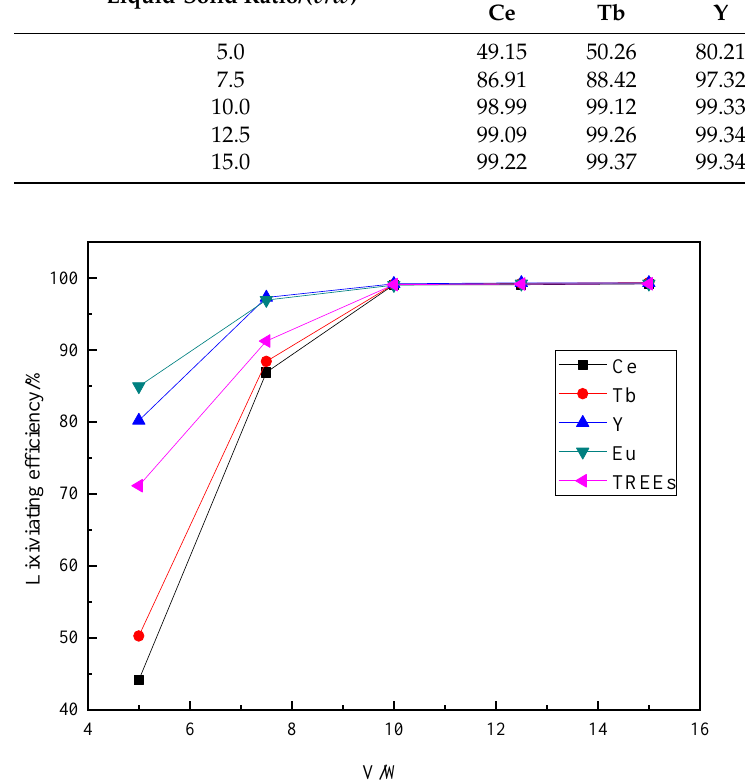
Table 9. Extraction efficiency of Ce, Tb, Y, Eu, and total rare earth under different liquid–solid ratios (oxygen concentration in the mixed gas of 0.4%, roasting temperature of 700 °C, roasting time of 2.5 h, material ratio of phosphor powder to alkali 1:3, HCl solution concentration of 4 mol·L −1 , acid leaching temperature of 60 °C, and acid leaching time of 1 h). Extraction Efficiency/% Liquid-Solid Ratio/( v / w )